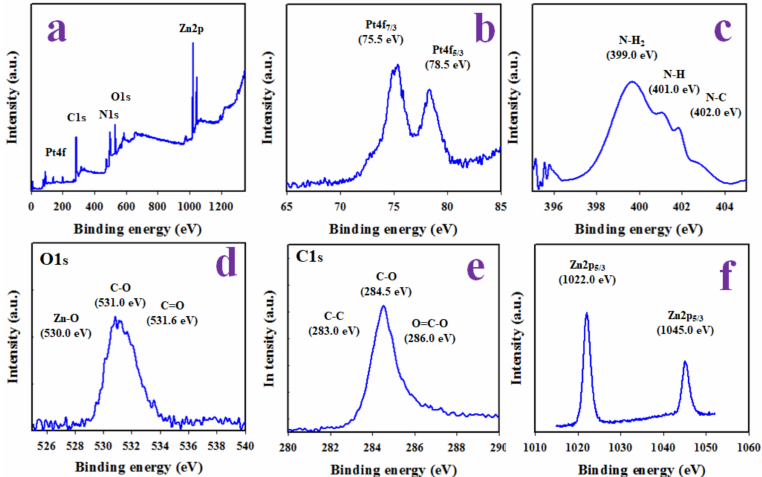
Figure 5. XPS analysis of Pt-NPs-embedded PPy-CB@ZnO NCs; ( a ) survey spectrum, ( b ) Pt4f, ( c ) N1s, ( d ) O1s, ( e ) C1s, and ( f )